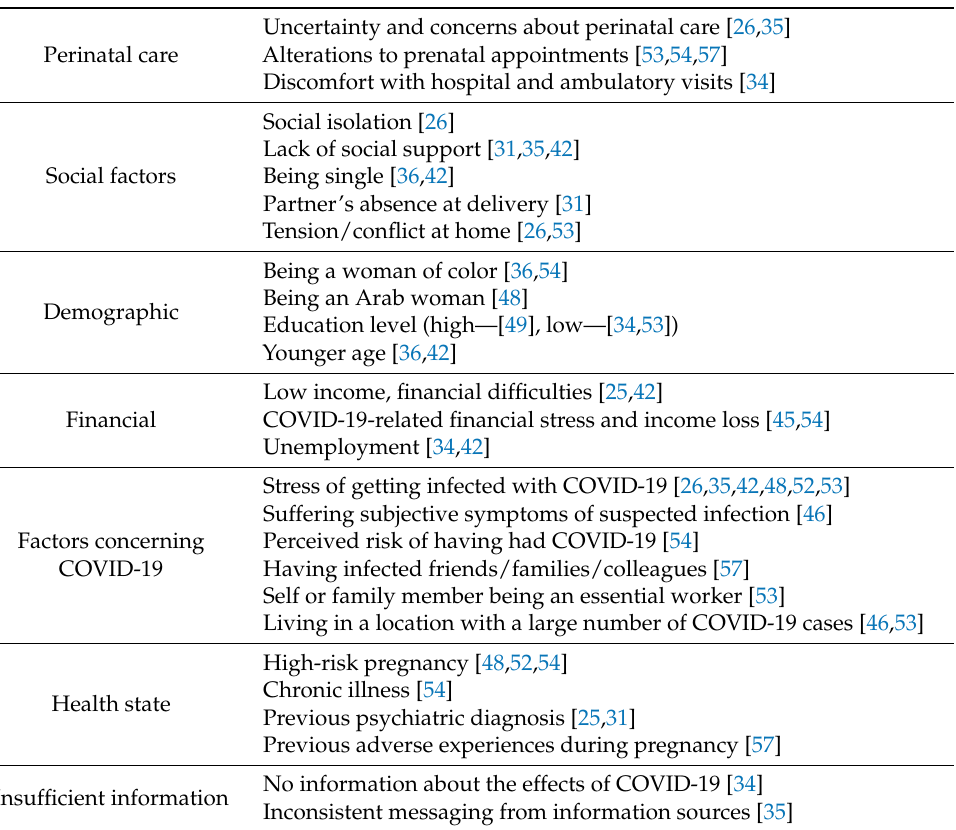
Table 3. Risk factors of depression and/or anxiety